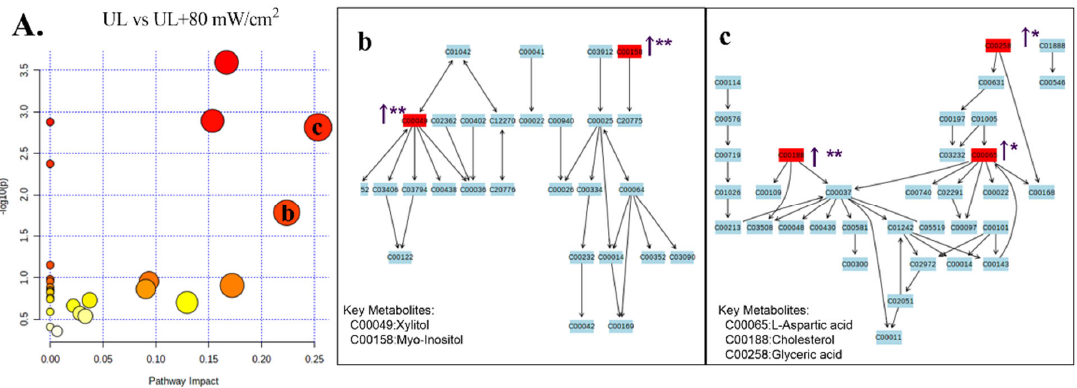
Figure 10. ( A ) Differential metabolic pathways between UL and 80 mW/cm 2 groups. The color (light to dark) of the point represents the p value (Y-axis), and the size of the point represents the metabolic pathway impact (X-axis). ( A ( b )): alanine, aspartate and glutamate metabolism; ( A ( c )): glycine, serine and threonine metabolism. * p < 0.05 vs. UL group, ** p < 0.01 vs. UL group.